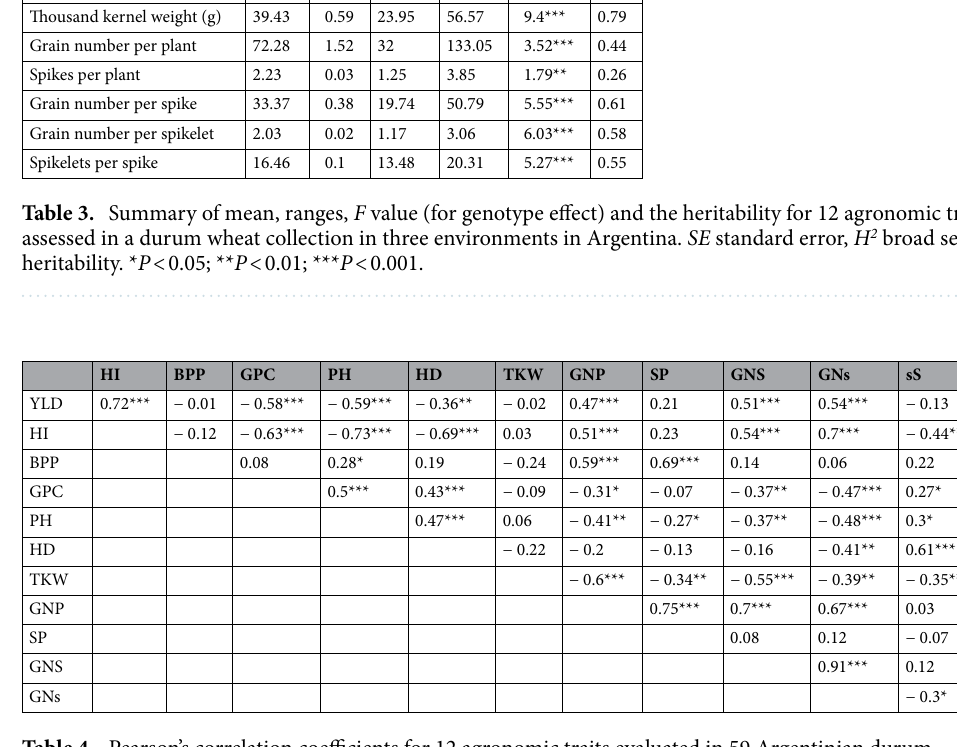
(Fig. 3B). PC1 and PC2 were associated with negative and positive values for heading date, respectively, tending to separate the Ppd-A1 allelic variants according to the two components (Fig. 3C). A clear relationship between the groups previously described (Q1–3 and M) and the PCA was not evident (Fig. 3D). The effect of the allelic variants at the Rht-B1 and Ppd-A1 loci and the groups defined by STRU CTU RE was evaluated for all the traits. The analysis of variance showed significant differences between the STRU CTU RE groups in seven out of 12 traits (Table 5). Significant differences in grain yield were only observed for Q1, which showed a 30% reduction, on average, in grain yield relative to Q2, Q3 and M. The Q1 group also showed a lower harvest index and higher plant height and grain protein content (10.8, 13.5 and 5.9% on average, respectively) than the others. On the other hand, Q3 and the admixture groups showed higher grain number per spikelet (13.4%) and grain number per spike (12.6% on average) relative to Q1 and Q2 (Table 5). The allelic variants at Rht-B1 and Ppd-A1 showed significant differences in nine out of 12 evaluated traits (Table 5). The genotypes carrying the semi-dwarfing Rht-B1b allele had an increase in grain yield of 1483 kg ha −1 ( P < 0.001) relative to the genotypes carrying the Rht-B1a , whereas the genotypes with the Ppd-A1a allele (confer- ring photoperiod insensitivity) showed increases of 314 kg ha −1 relative to the ones carrying the Ppd-A1b , but this was not significant ( P = 0.063) (Table 5). Moreover, genotypes carrying the Rht-B1b or the Ppd-A1a alleles had on average a shorter time to heading (4.8 or 5.9 days earlier, respectively) than those carrying the other allele (Table 5). In both cases, genotypes carrying the Rht-B1b or the Ppd-A1a alleles also showed significant reduc- tions in plant height and grain protein content, and significant increases in harvest index, spikes per plant and grain number-related traits relative to the genotypes carrying the other alleles ( Rht-B1a or Ppd-A1b ) (Table 5). Furthermore, the genotypes with different alleles at Ppd-A1 significantly differed in the number of spikelets per spike. No significant differences were found in the aerial biomass and thousand kernel weight for either STRU CTU RE groups or for the allelic variants (Table 5).